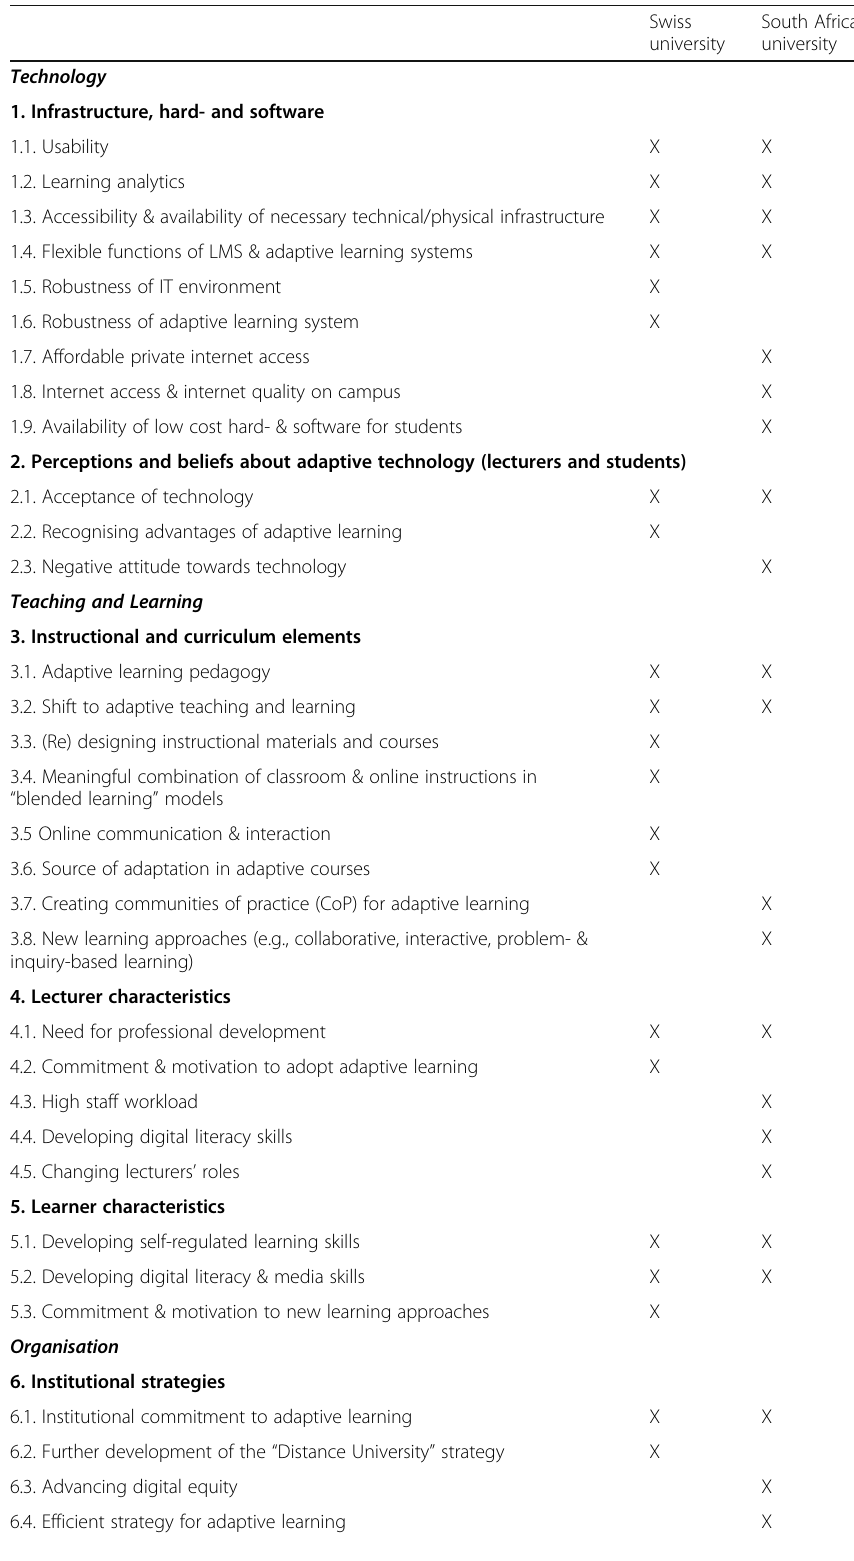
Table 2 Full List of Challenges of Adaptive Learning by Dimensions and